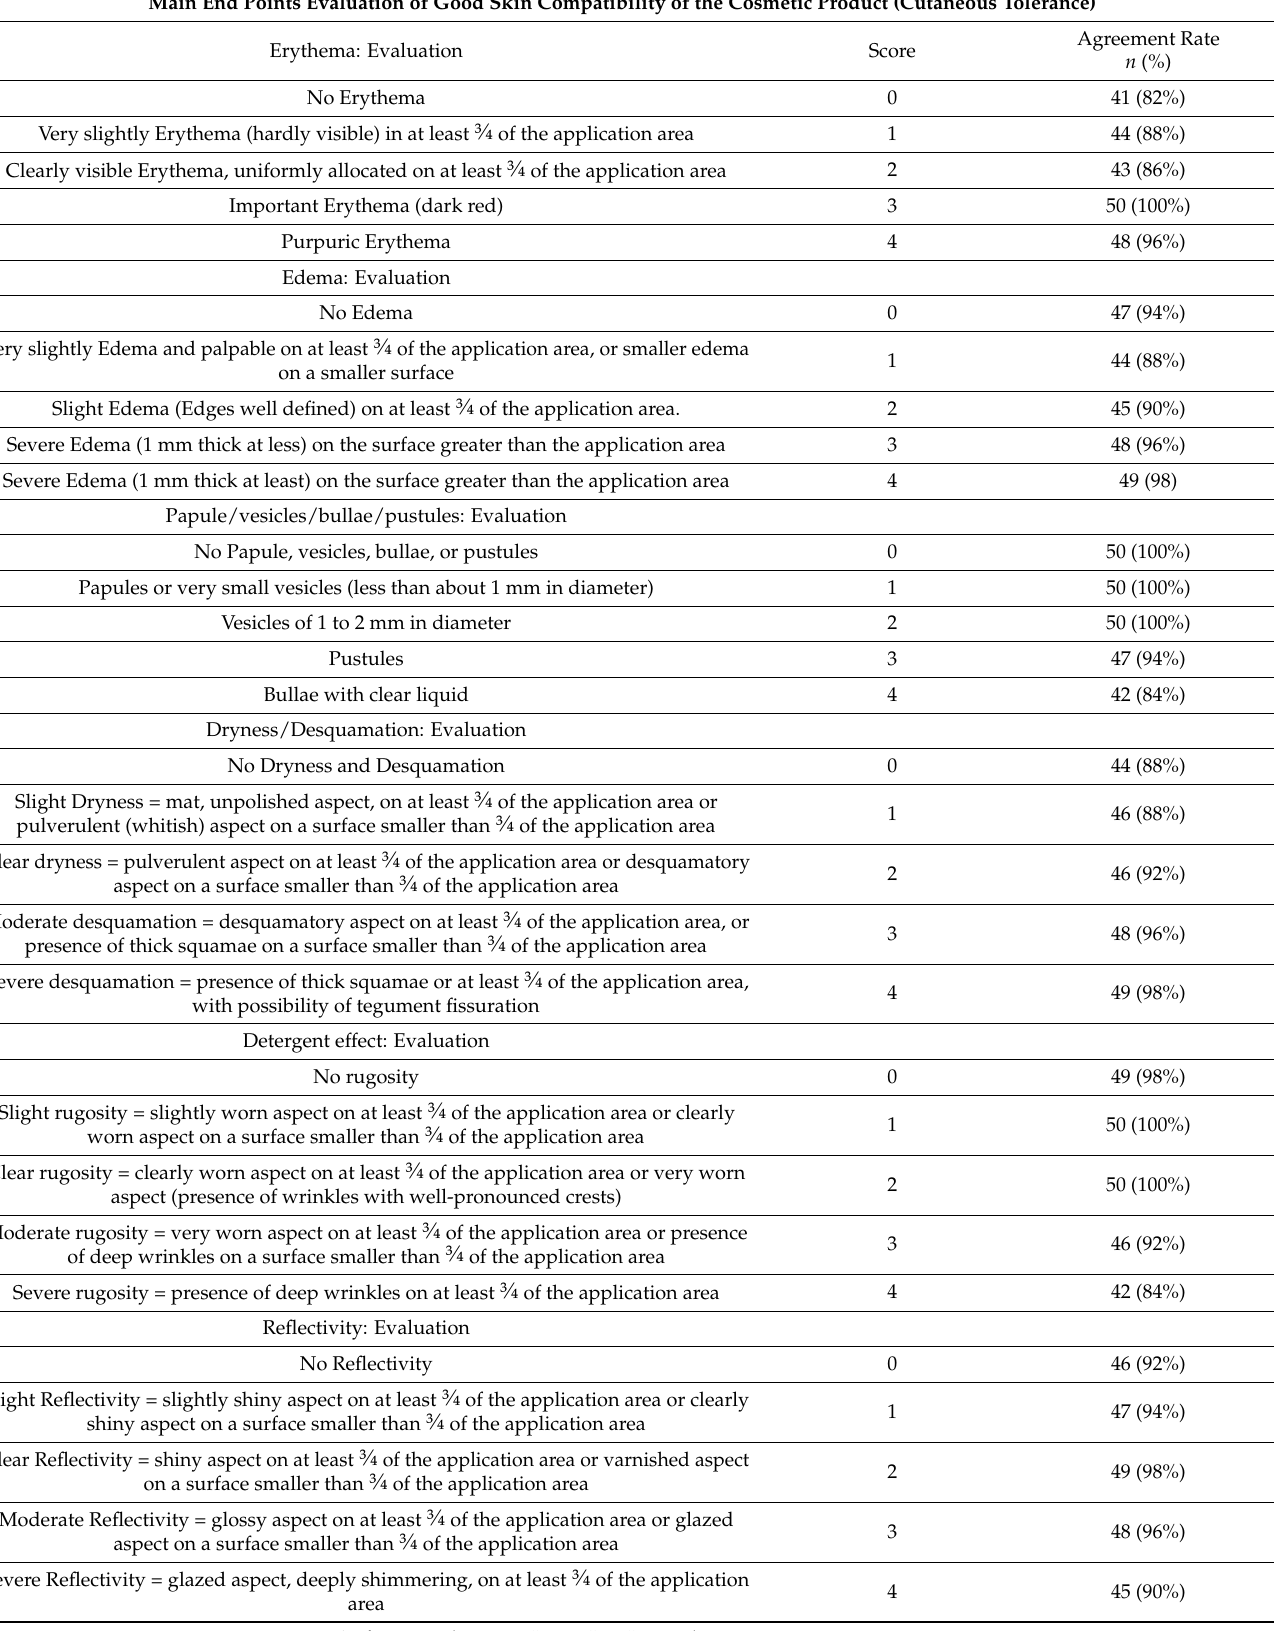
Table 2. Final cutaneous tolerance and good skin compatibility items.